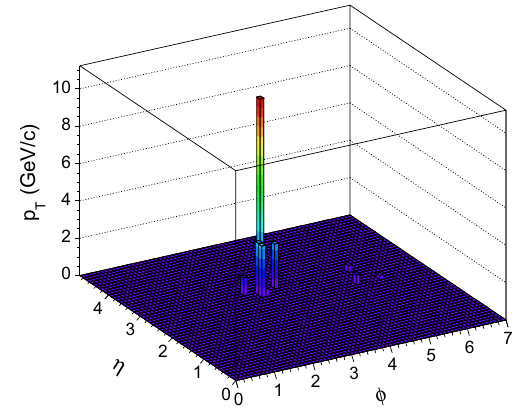
Fig. 1 A typical PYTHIA simulated jet event of jet E T > 20 GeV falling on forward rapidity (2.3 < η < 3.9) in pp collisions at 7TeV